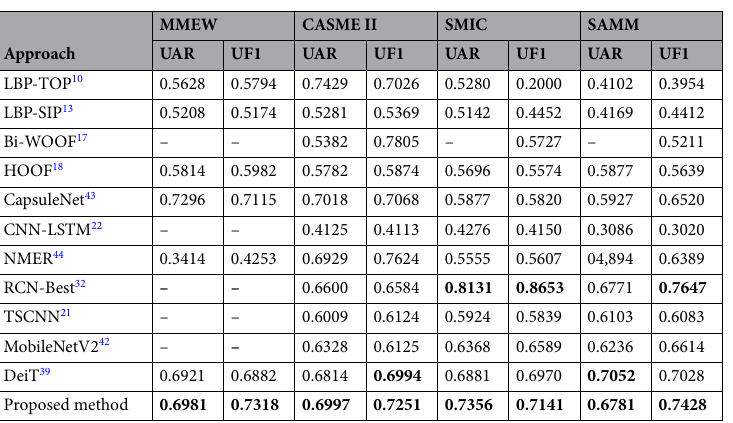
Table 3. UAR and UF1 performance of different approach under LOSO protocol on different datasets. The optimal results of two experiments on different datasets are shown in